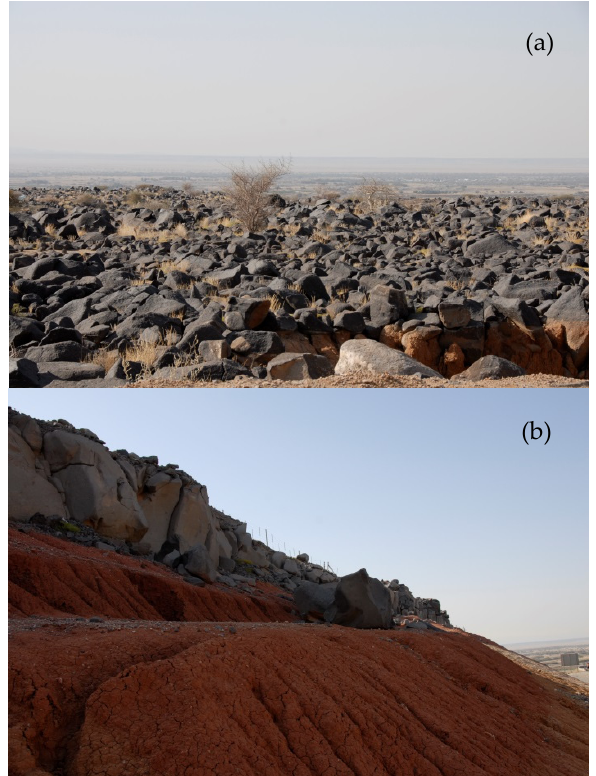
Figure 7. Stacked sequence of fining upward beds showing sediment composition and hydraulic connection to the perimeter fractured rock. Note that the vertical scale is what would be expected if all of the beds were preserved within a 5 m increment. It is expected that many mud layers have been removed in some reaches of the wadi, particularly the distal and middle sections, but in all cases there are at least three full beds preserved.